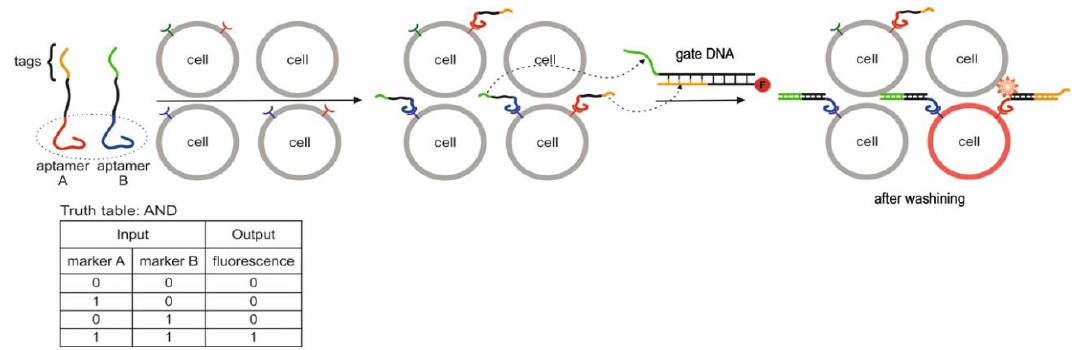
Figure 16. The AND logic gate. F = fluorescent label. Adapted from Reference [40]. Copyright © 2020 American Chemical Society. Further permissions related to the material excerpted should be directed to the ACS.